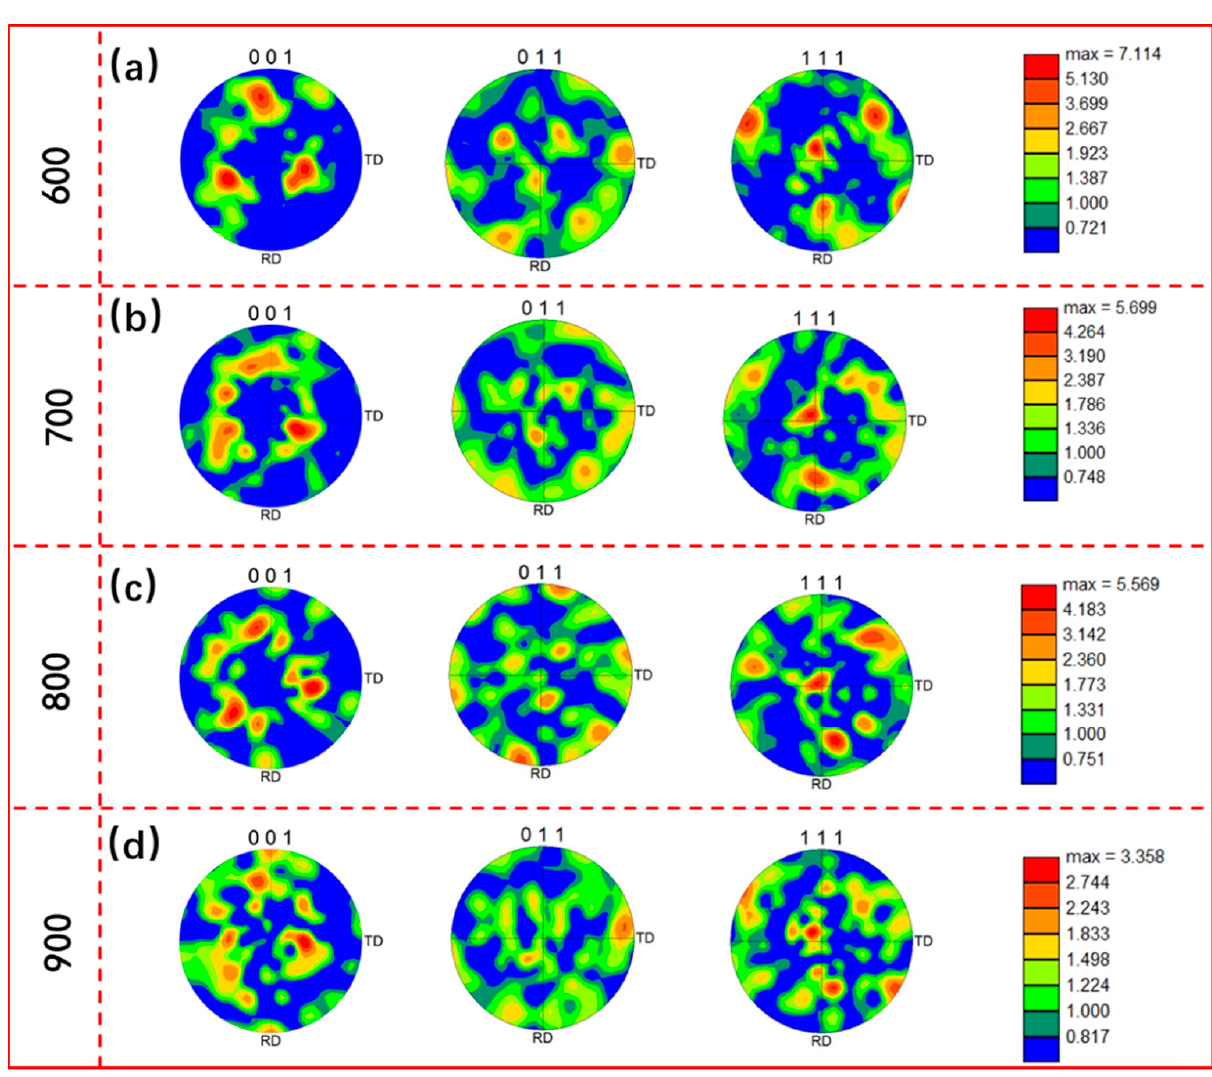
Figure 8. PF maps measured from top view of samples fabricated at four scanning rates: ( a ) 600, ( b ) 700, ( c ) 800, and ( d ) 900 mm/s.